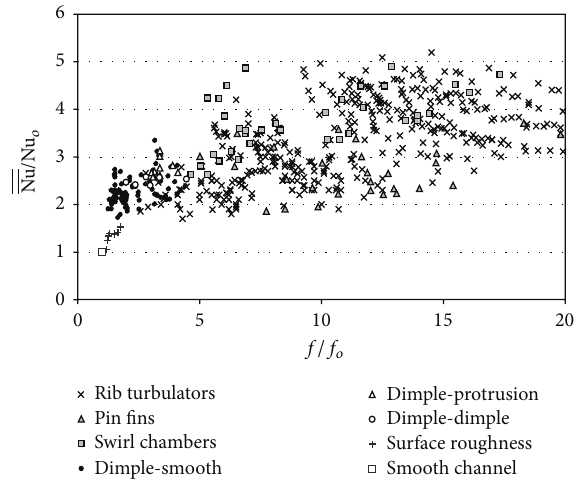
Figure 3: Comparison of relative performance of rib turbulators, pin fins, swirl chambers, dimple-smooth arrangements, dimple- protrusion arrangements, dimple-dimple arrangements, surface roughness, and smooth-walled channels from investigations prior to 2003. Globally averaged Nusselt number ratios Nu / Nu 𝑜 are presented as dependent upon friction factor ratios 𝑓/𝑓 𝑜